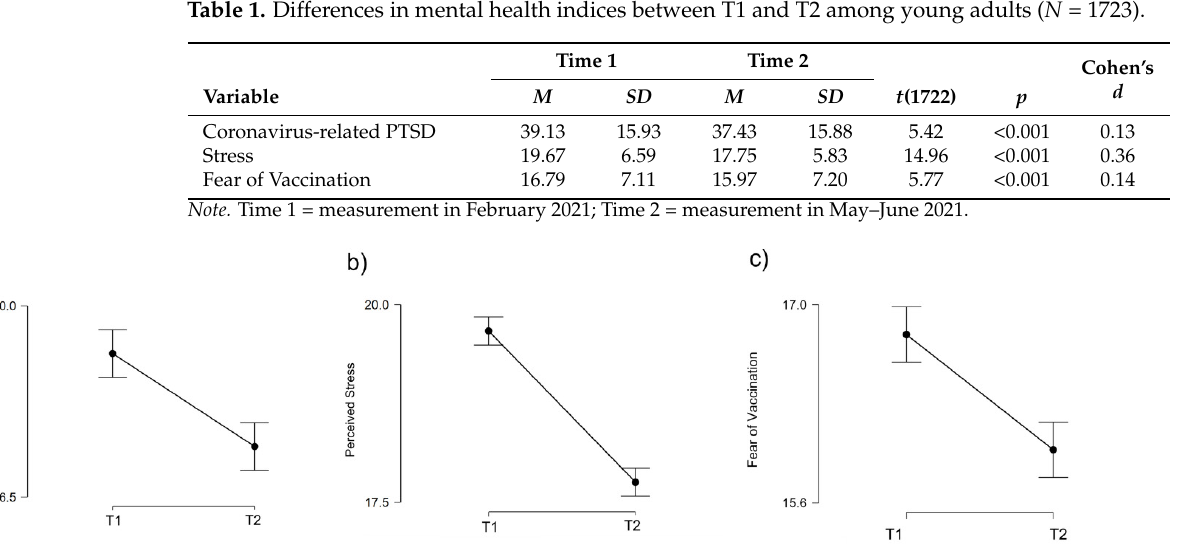
Figure 2. Changes in mental health indices: ( a ) coronavirus-related post-traumatic stress disorder (PTSD); ( b ) perceived stress; and ( c ) fear of vaccination among young adults at the first measurement timepoint (T1) in February 2021 and the second measurement (T2) in May–June